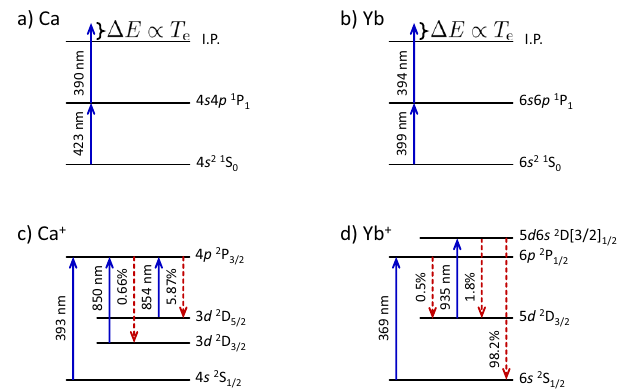
Fig. 5 Atomic energy levels and laser wavelengths. Blue arrows in a and b indicate the lasers used for ionizing Ca and Yb, respectively. The electron energy is given by the difference between the ionization limit and the laser photon energy. c , d show levels used in Ca + and Yb + spectroscopy, respectively. The blue arrows indicate the laser-driven transitions while the red dashed arrows indicate the spontaneous emission with the associated branching fractions. In this experiment, we use a Ti:sapphire laser to repump the 854 nm transition in Ca + . Repumping the transition at 850 nm does not change the measured results. We do not repump the 935 nm transition in Yb + .